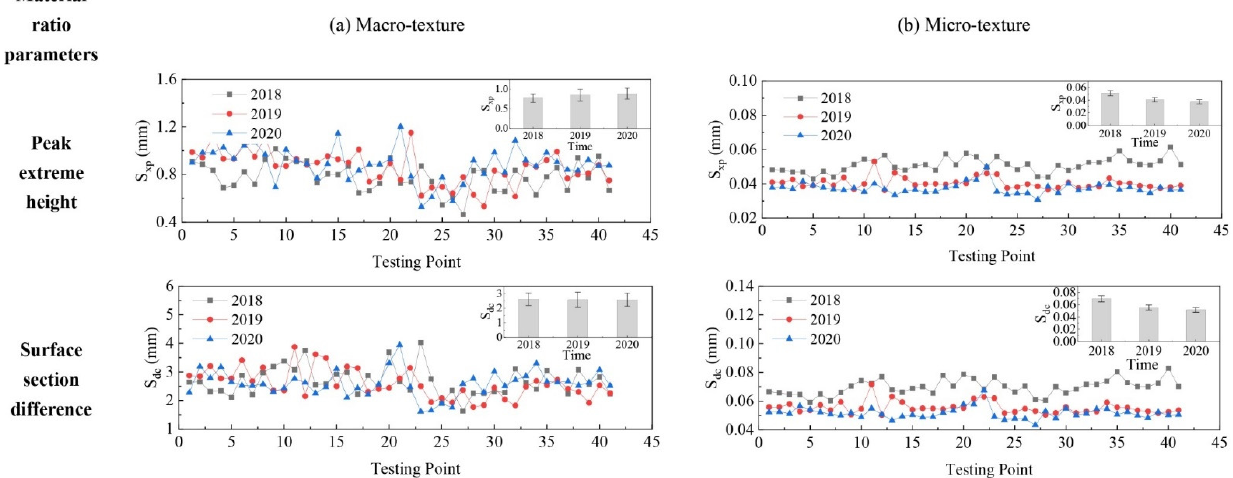
Figure 11. Pavement texture variations via material ratio parameters: ( a ) Macro − texture, and ( b ) Micro − texture.